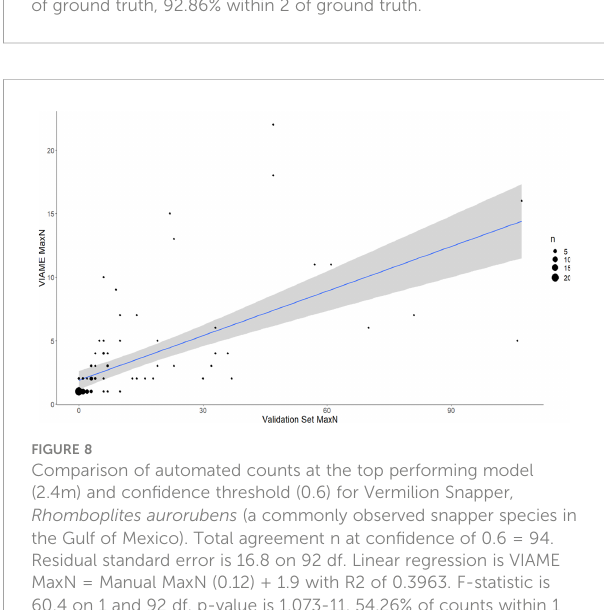
FIGURE 7 Comparison of automated counts at the top performing model (2.4m) and con fi dence threshold (0.7) for Scamp, Mycteroperca phenax (a commonly observed grouper species in the Gulf of Mexico). Total agreement n at con fi dence of 0.7 = 42. Residual standard error is 1.64 on 40 df. Linear regression is VIAME MaxN = Validation Set MaxN * (0.37) + 0.86 with R2 of 0.3847. F-statistic is 25.01 on 1 and 40 df, p-value is 1.81e-5. 80.95% of counts within 1 of ground truth, 92.86% within 2 of ground truth.